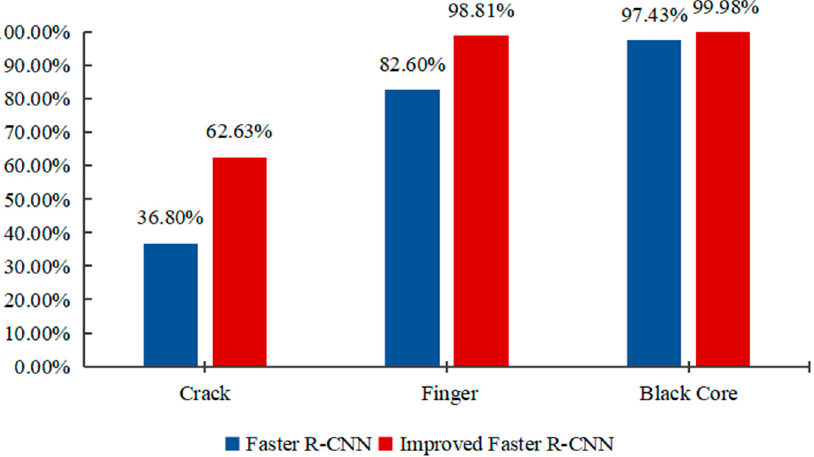
Figure 10. Comparison of the average accuracy of the original Faster R-CNN and this paper. Table 3. Results of experiments with different improvement